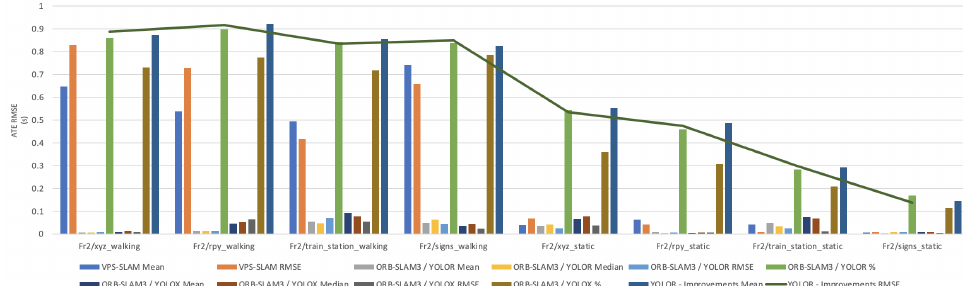
Figure 14. Overall Absolute Trajectory Error (RMSE) distribution.